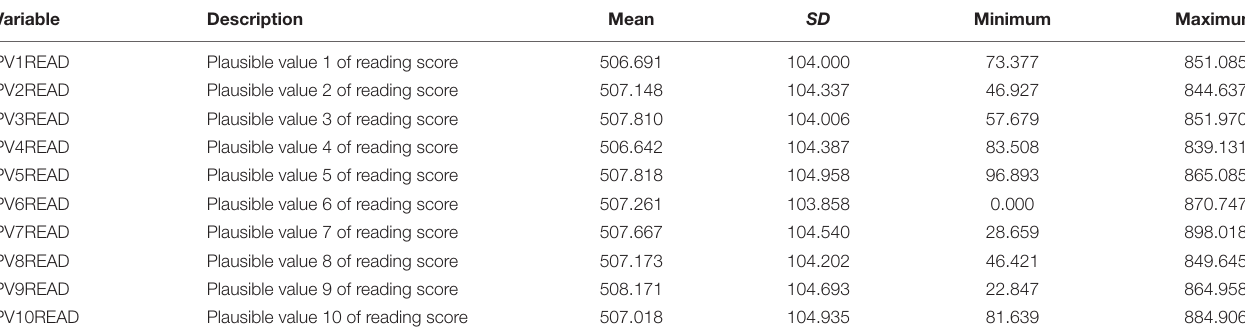
TABLE 2 | Descriptive statistics of plausible values of reading proficiency in the PISA 2015 computer-based reading assessment.